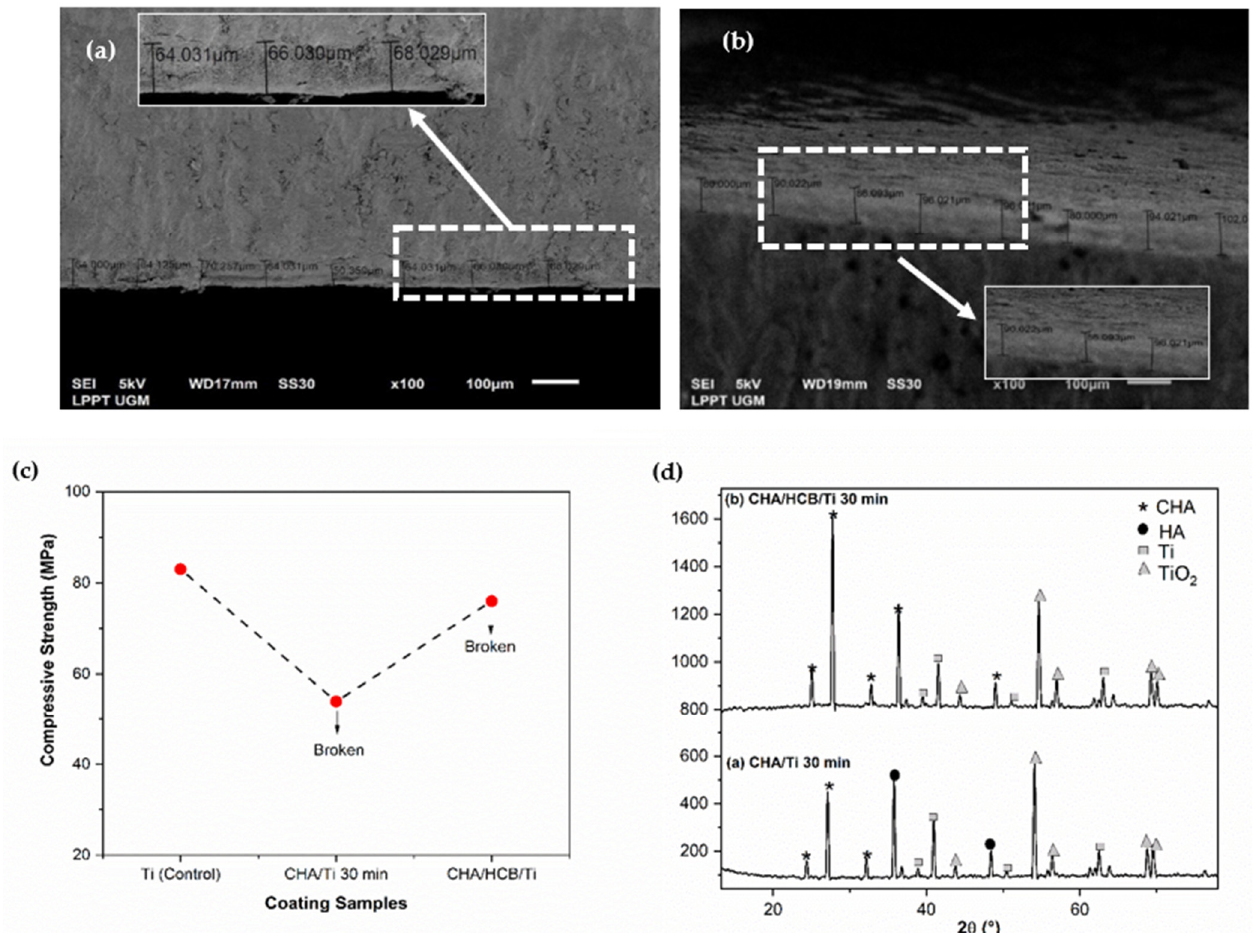
Figure 2. Physicochemical and mechanical properties of coating samples. ( a ) Cross-section of CHA/Ti 30 min, ( b ) cross-section of CHA/HCB/Ti 30 min, ( c ) compressive strength graph, and ( d ) crystallographic properties of samples [7].